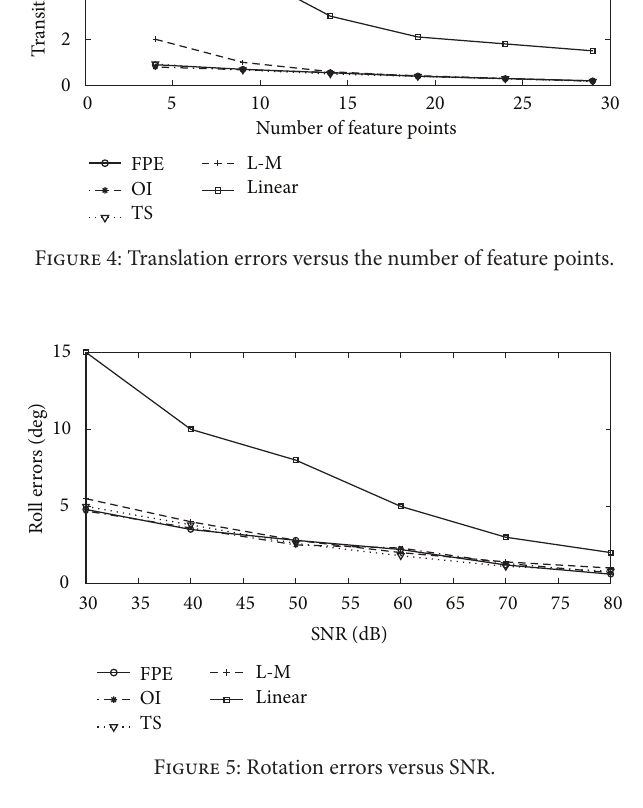
1000 sets of are generated for each set 󵰃󵰃𝐰𝐰 𝑖𝑖